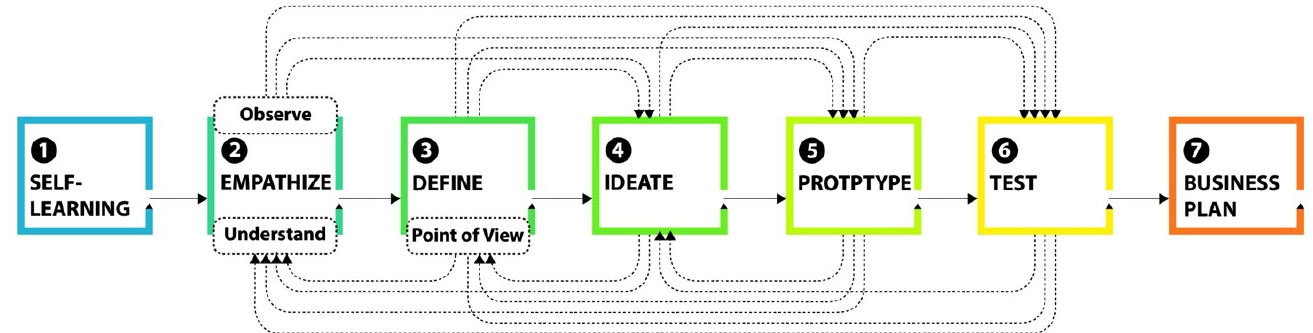
Figure 3. The design thinking process model modified according to the knowledge of media management. (According to ref. [70], this figure is painted by this article).